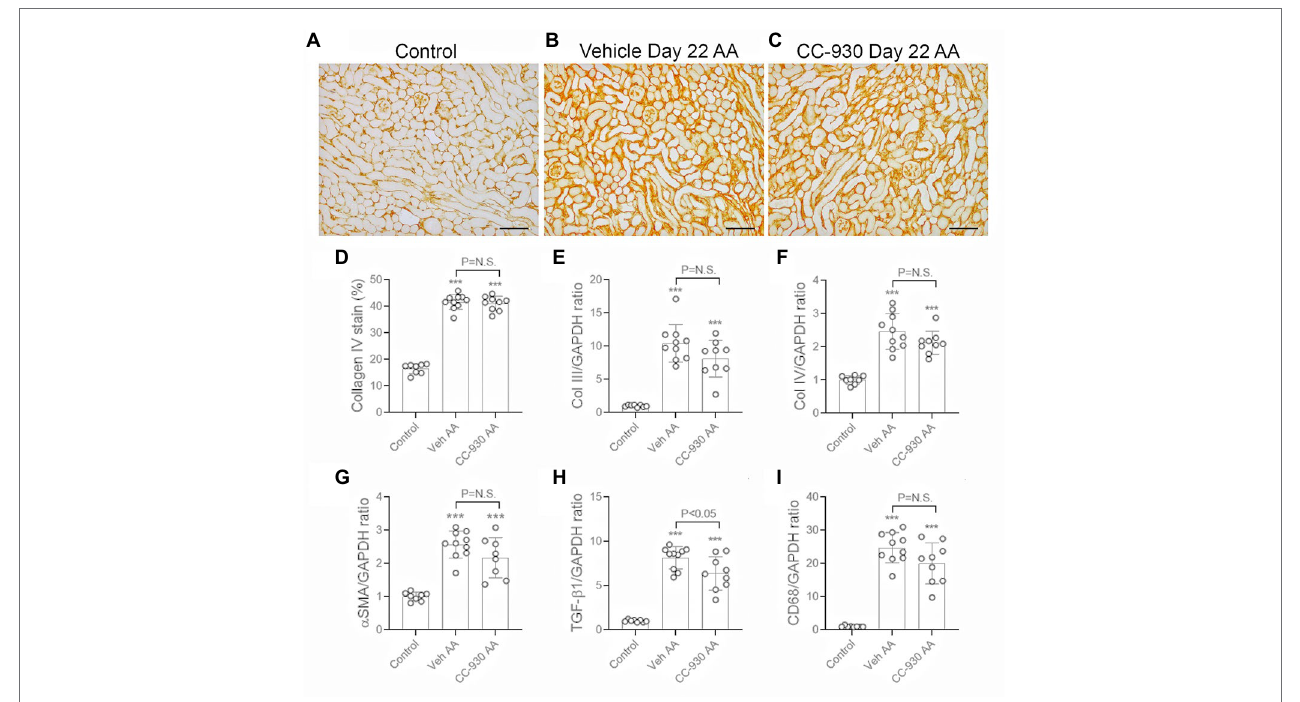
FIGURE 8 | Renal fibrosis on day 22 of AA-induced chronic kidney disease. Vehicle and CC-930 treated AA groups were compared to normal controls. (A–C) Immunohistochemistry staining for collagen IV. (A) Normal mouse kidney showing collagen IV in the tubular and glomerular basement membranes. (B) Vehicle treated day 22 AA shows increased interstitial collagen IV staining, particularly in areas with atrophic tubules. (C) CC-930 treated day 22 AA shows a similar increase in interstitial collagen IV deposition as seen with vehicle treatment. Bars represent 100 μ m. (D) Graph showing quantification of the area of interstitial collagen IV staining. RT-PCR analysis of: (E) Collagen III; (F) Collagen IV; (G) α -SMA/Acta2; (H) TGF- β 1, and (I) CD68. One-way ANOVA with Tukey’s multiple comparison test. *** p < 0.001 vs. control. N.S., not